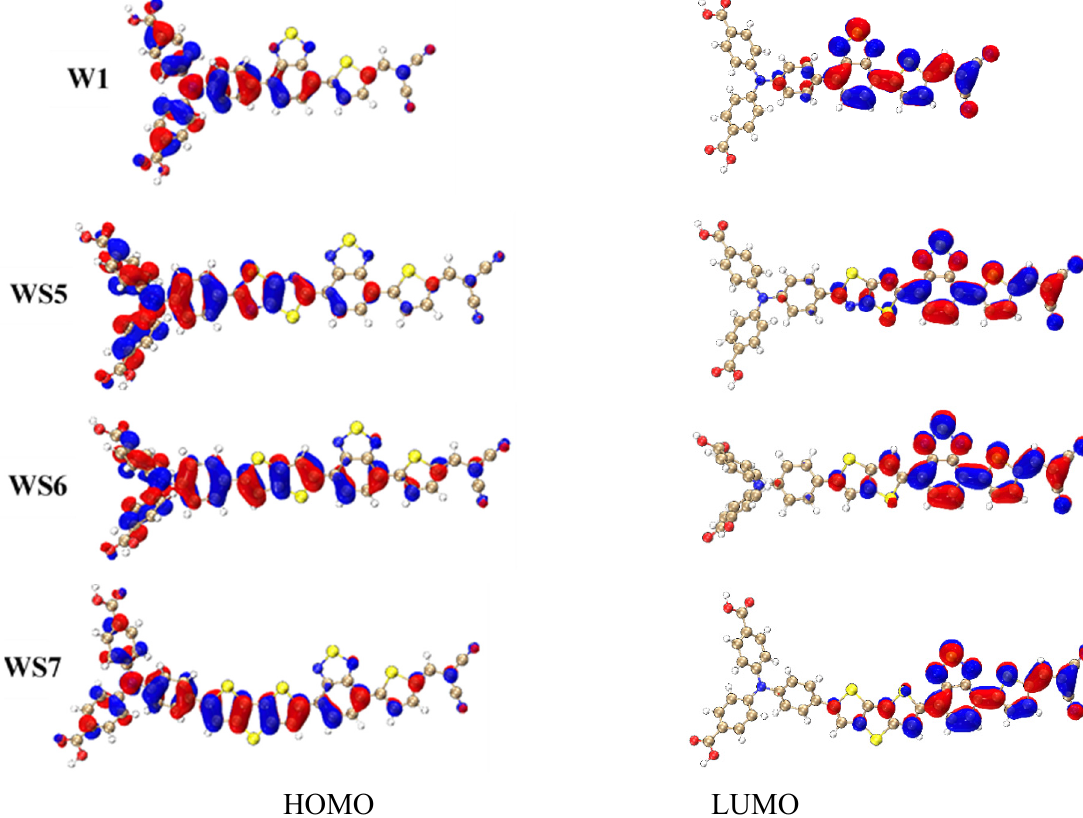
Figure 4. Geometrically optimized structures of W1, WS5, WS6, and WS7, and the electron density distributions of their HOMOs and LUMOs.